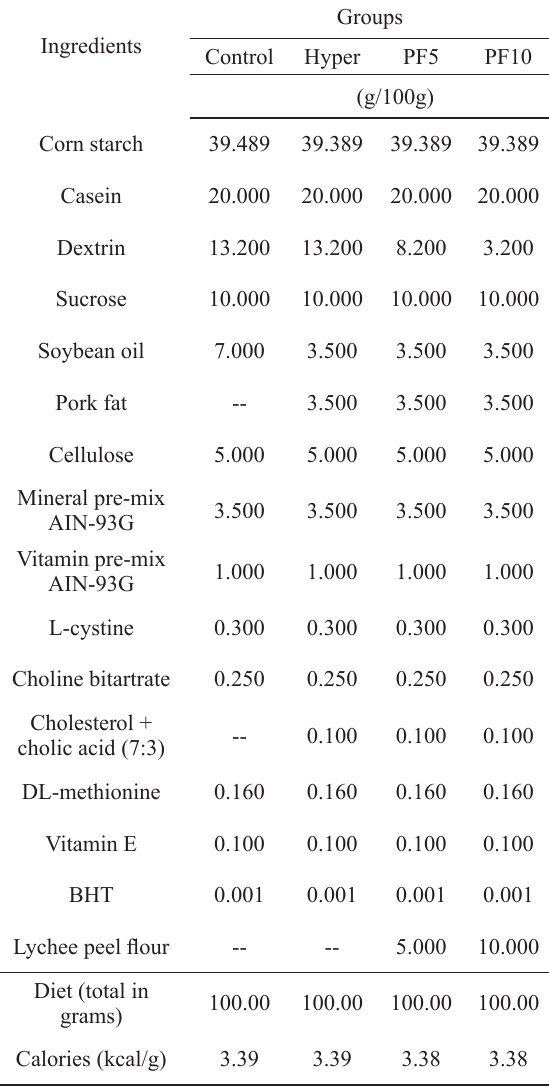
Percent composition of the four diets characterized by the different treatments administered to the experimental